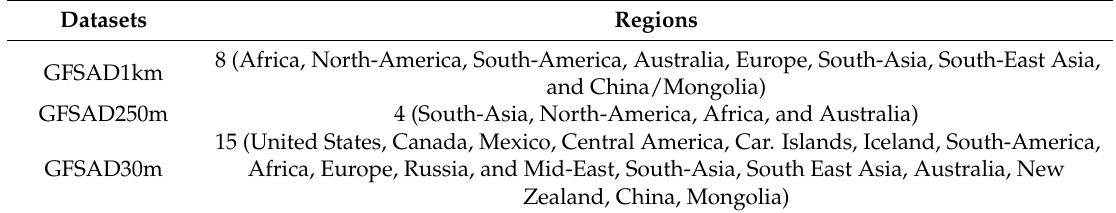
Table 4. The list of regions used in the assessment of the three different GFSAD cropland extent maps Datasets